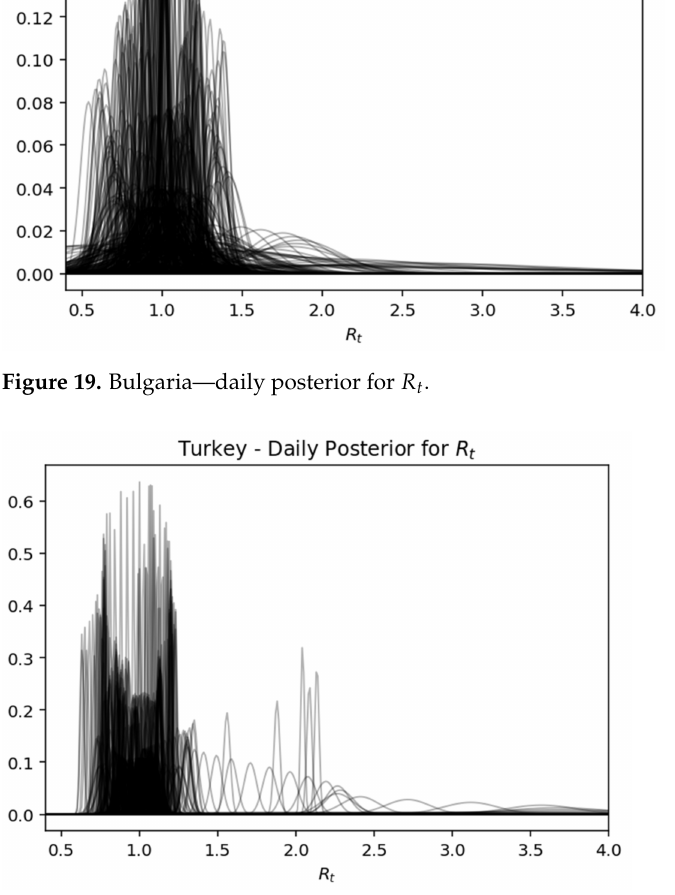
Figure 20. Turkey—daily posterior for R t